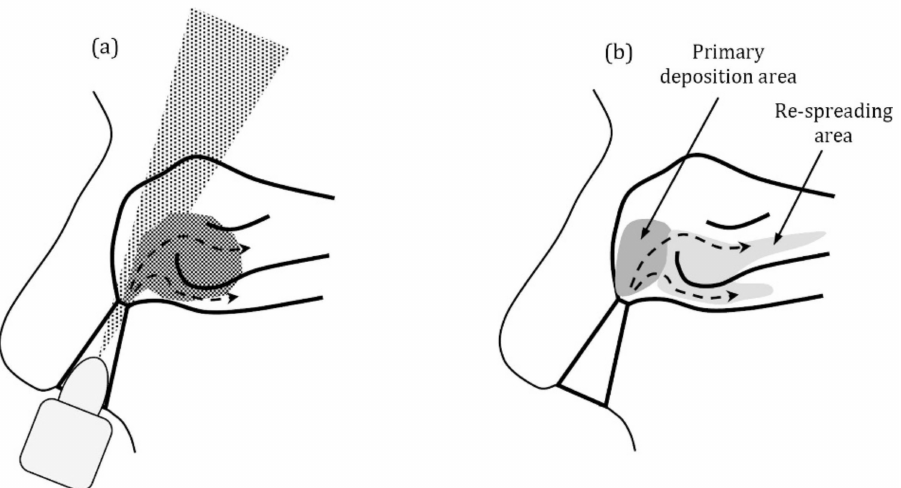
Figure 6. Proposed mechanisms of drug penetration during the simultaneous air inspiration: ( a )—droplet entrainment by air during spray application (probably less important for large droplets), ( b )—spreading of already deposited drug along the nasal surface due to the interactions with the air stream. Reproduced with permission from [62], Elsevier,